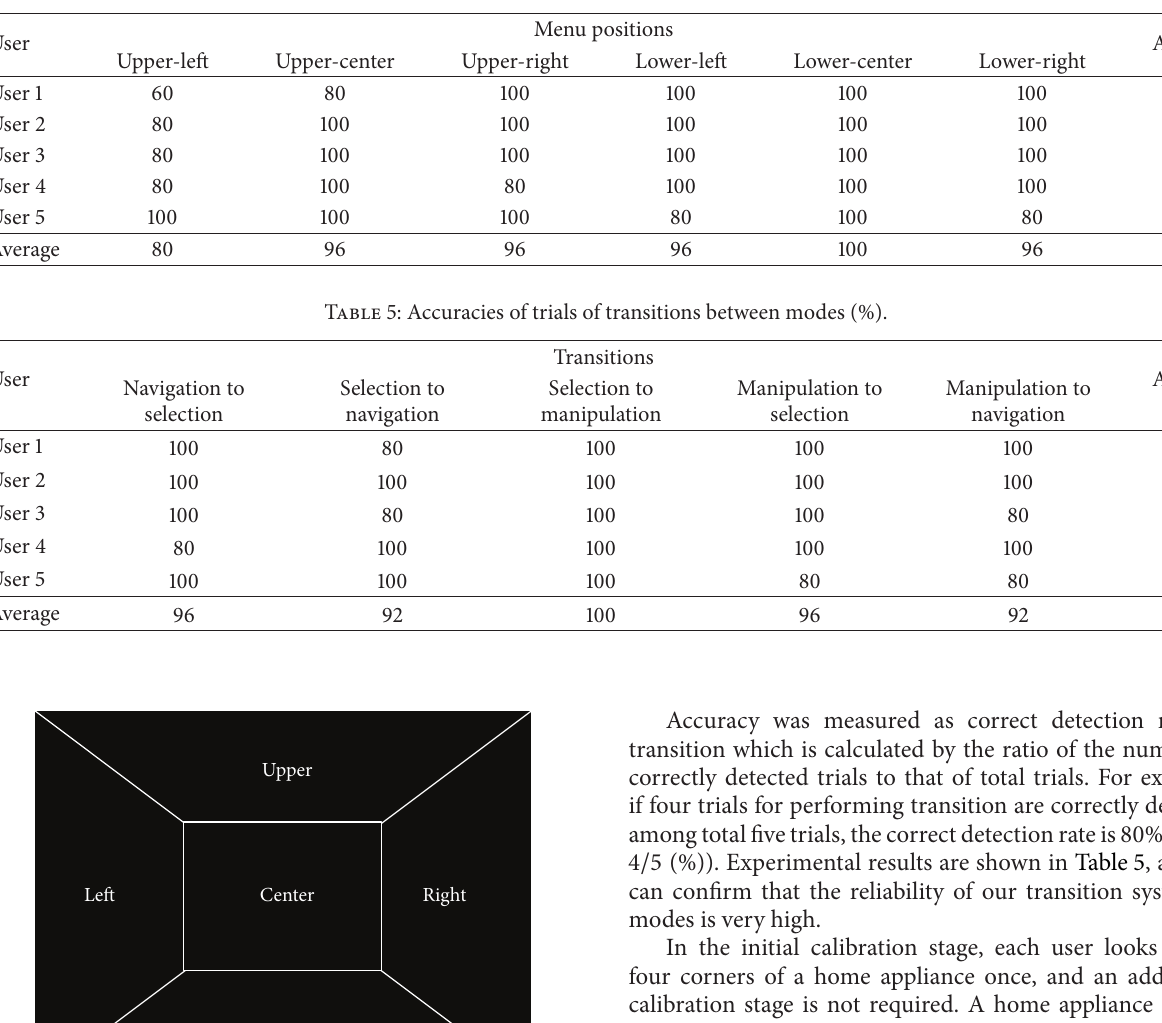
Table 4: Accuracies of trials of manipulation mode (%).